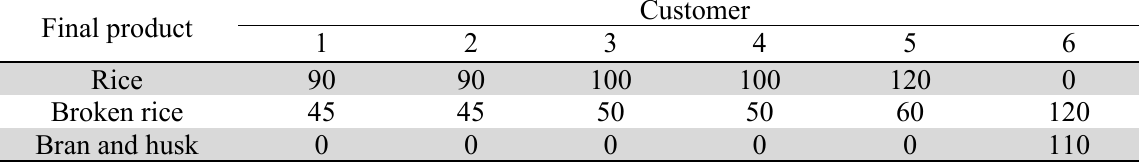
Selling price of final products in each customer zone (Iranian Million